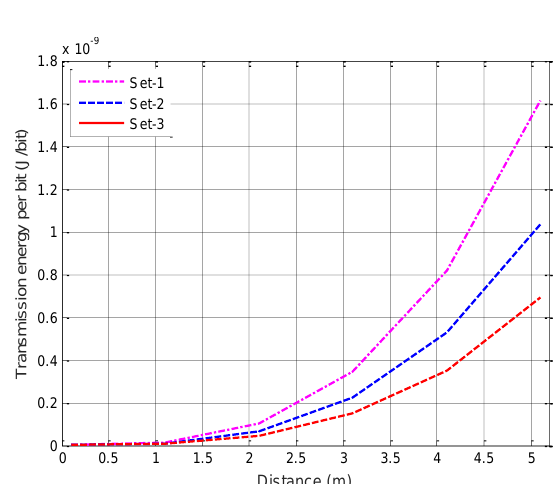
Figure 3. Transmission energy of each adaptive scheme as a function of distance between the hub and the WAP in 2I1O configuration.